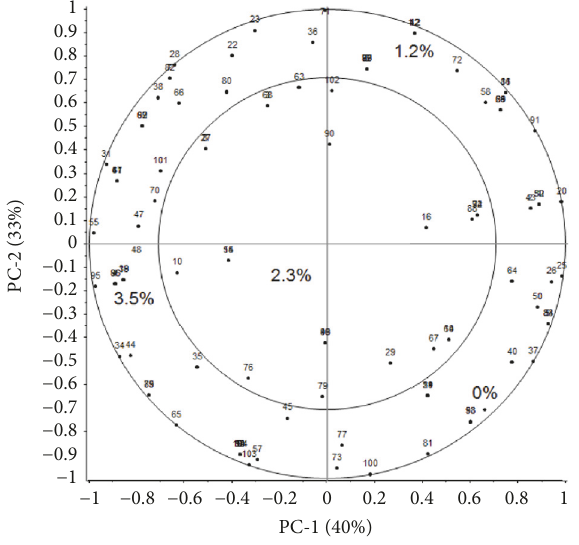
Figure 4: Internal Preference Map of consumers (n=104) who rated the overall liking for biscuits enriched with encapsulated grape skin extract at different levels (0, 1.2, 2.3, and 3.5% on dough